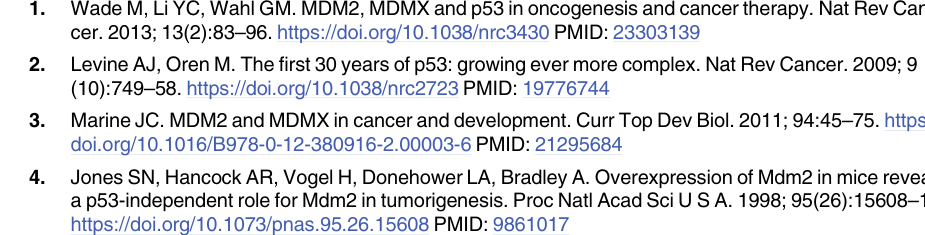
S2 Table. Analysis of mice from Mdm2 la/+ mice interbreeding. S3 Table. Test results of embryonic viability of Mdm2 la/+ heterozygous mice. S4 Table. Mdm4 overexpression does not rescue or delay the embryonic lethality of Mdm2 la/la